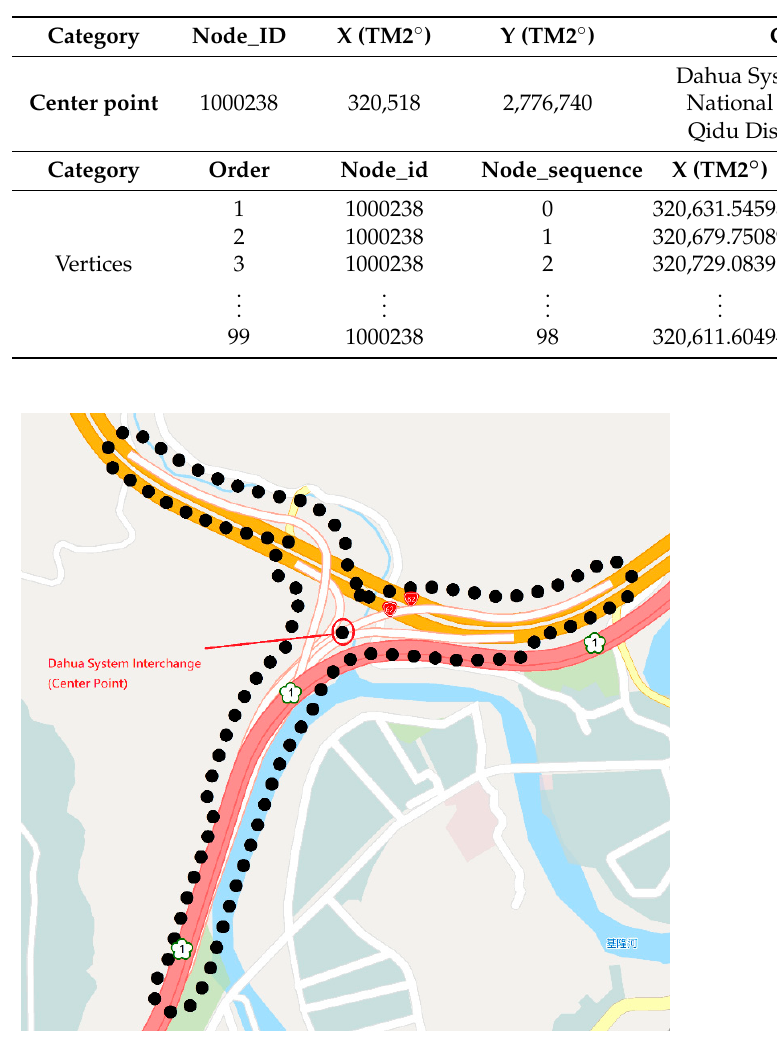
Figure 3. Illustrative example of interchange